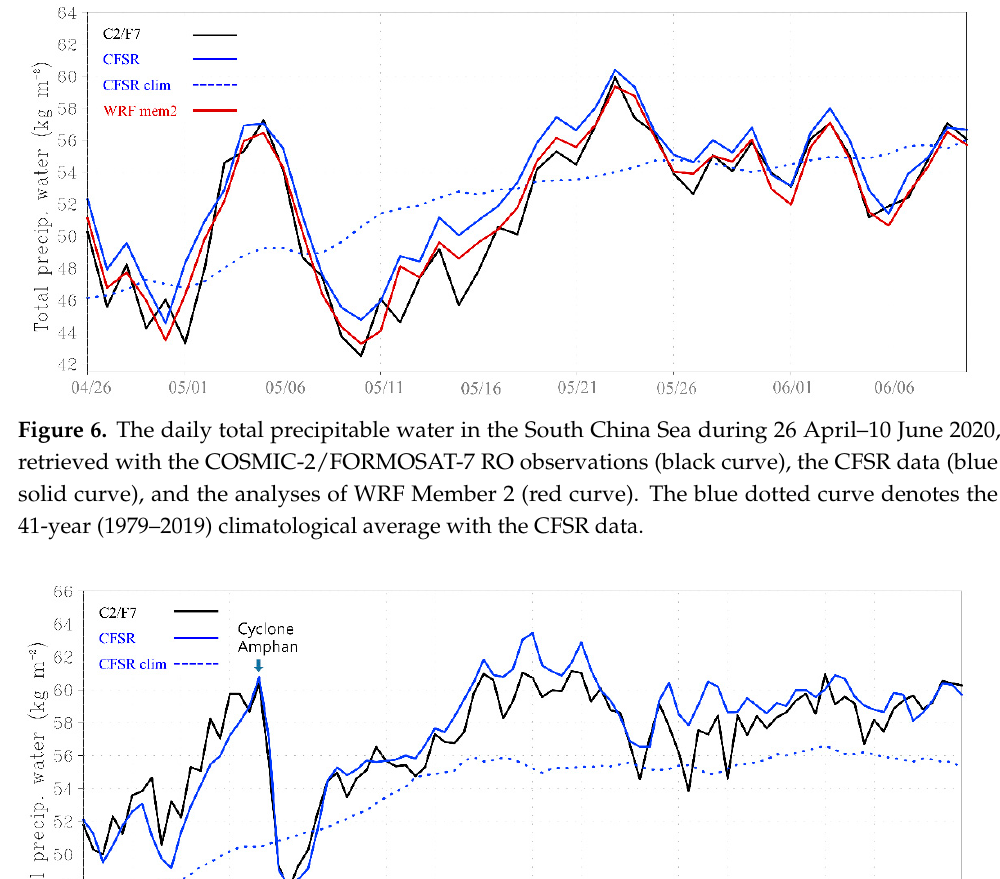
Figure 6. The daily total precipitable water in the South China Sea during 26 April–10 June 2020, retrieved with the COSMIC-2/FORMOSAT-7 RO observations (black curve), the CFSR data (blue solid curve), and the analyses of WRF Member 2 (red curve). The blue dotted curve denotes the 41- year (1979–2019) climatological average with the CFSR data.